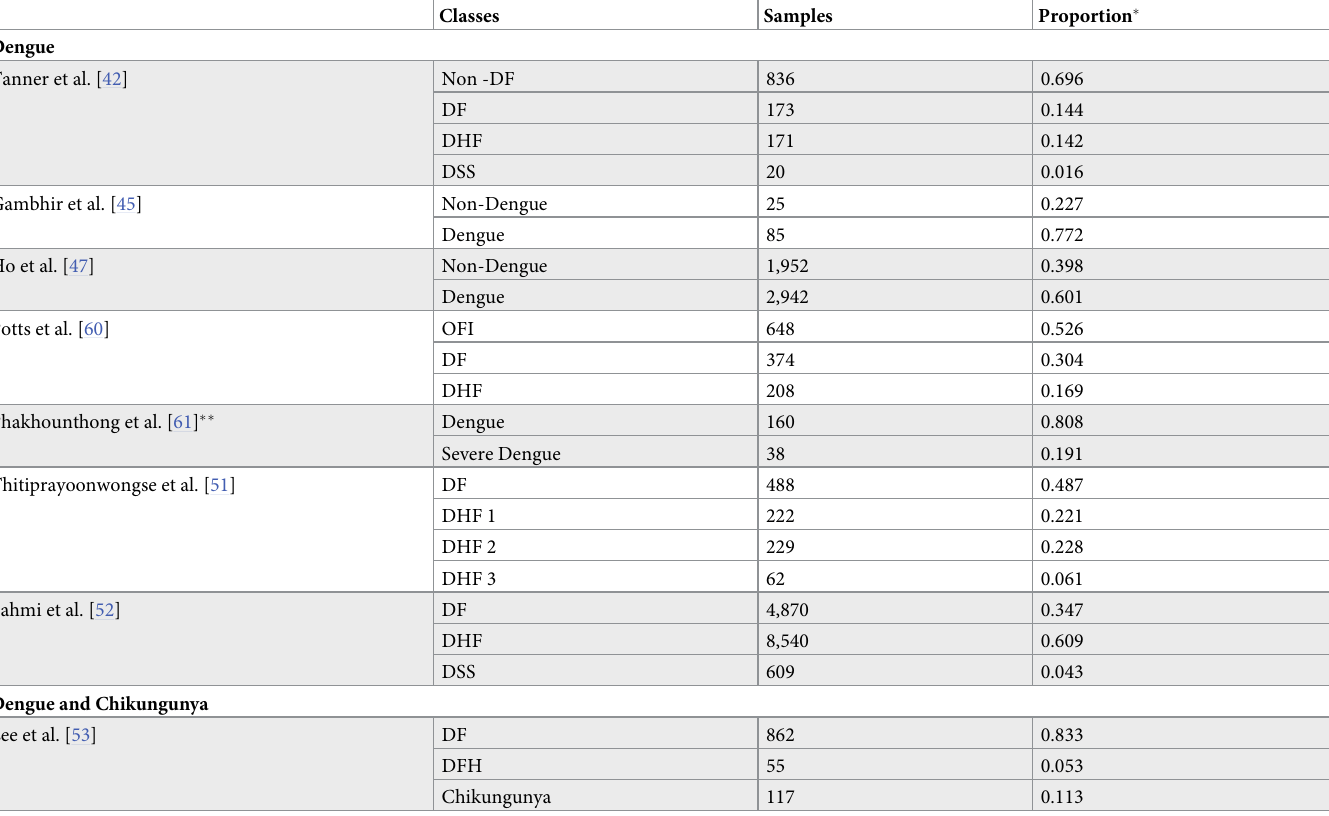
Table 3. Distribution of samples per classes. Classes Samples Proportion